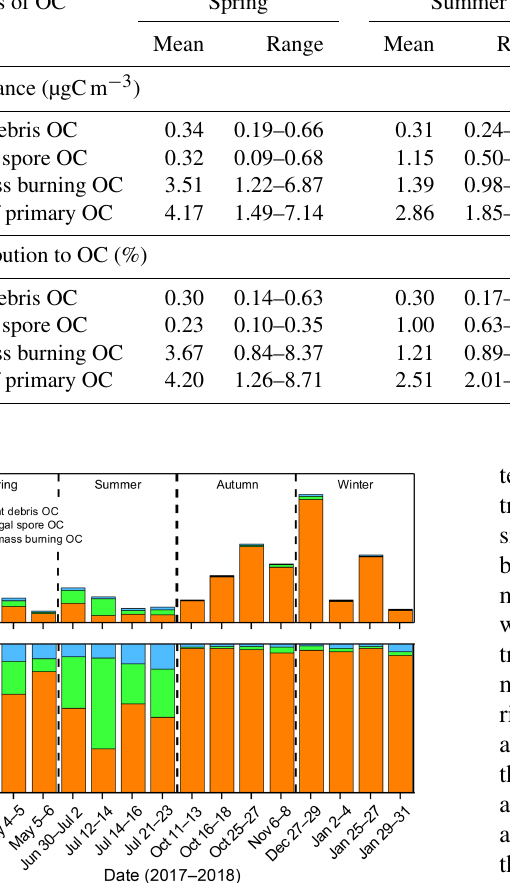
Table 5. Abundance of estimated primary OC (plant debris, fungal spores, biomass burning) and its contributions to OC in urban Beijing aerosols from April 2017 to January 2018. Sources of OC Spring